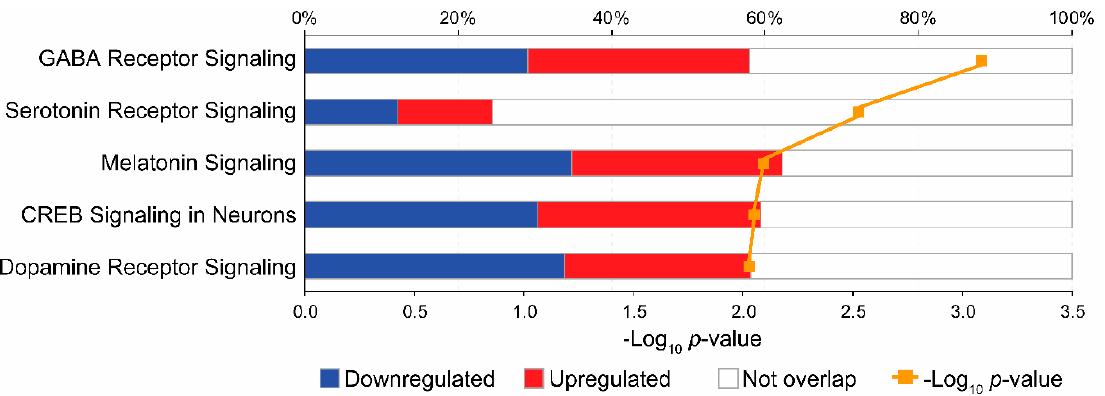
Figure 1. Proteomic profile identified by mass spectrometry-based untargeted proteomics. Proteins differentially expressed in the dorsolateral prefrontal cortex (DLPFC) of five individuals who died by suicide and five individuals who died by other causes (non-suicide) by having a false discovery rate (FDR) corrected p -values (Benjamini–Hochberg–Yekutieli procedure) < 0.3, absolute Log 2 fold change (FC) > 0.4, and no missing values in any of the samples. ( A ) Volcano plot showing the downregulated proteins (blue), upregulated (red) and proteins that did not meet criteria (gray). ( B ) Heat map reflecting the expression values of proteins of interest from the non-suicide and suicide cases. Samples of each group are arranged in columns, proteins in rows. Blue shades show decreased expression and red shades show increased expression.